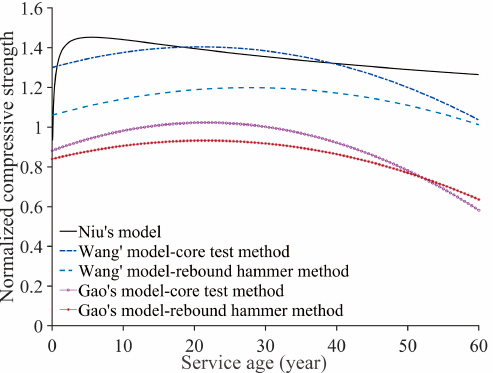
Figure 2. Comparison of the above models.